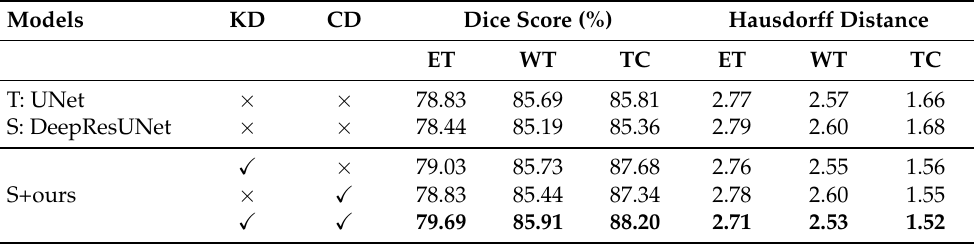
Table 4. Ablation experiments of our method on the BraTS2018 dataset. The teacher was UNet and the student was